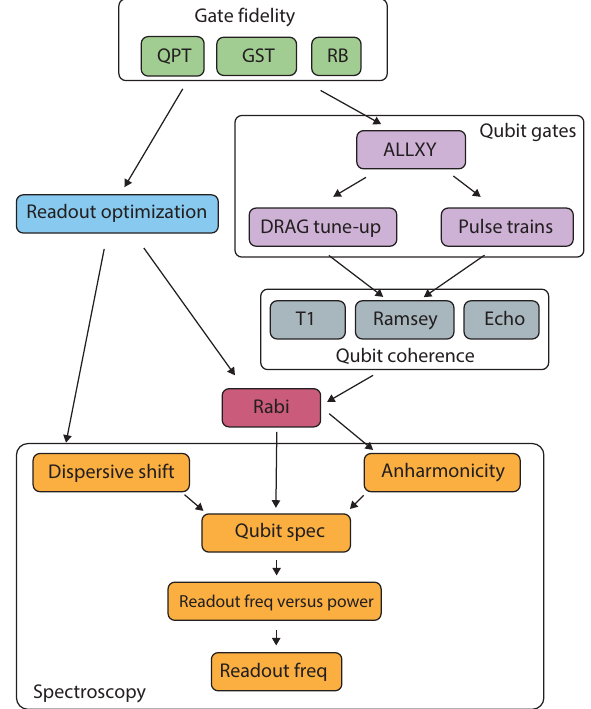
FIG. 9. Tuneup of a single flux-tunable qubit . The typi- cal process can be visualized as a dependency graph [163]. Nodes correspond to different calibration experiments, while edges denote dependencies between different